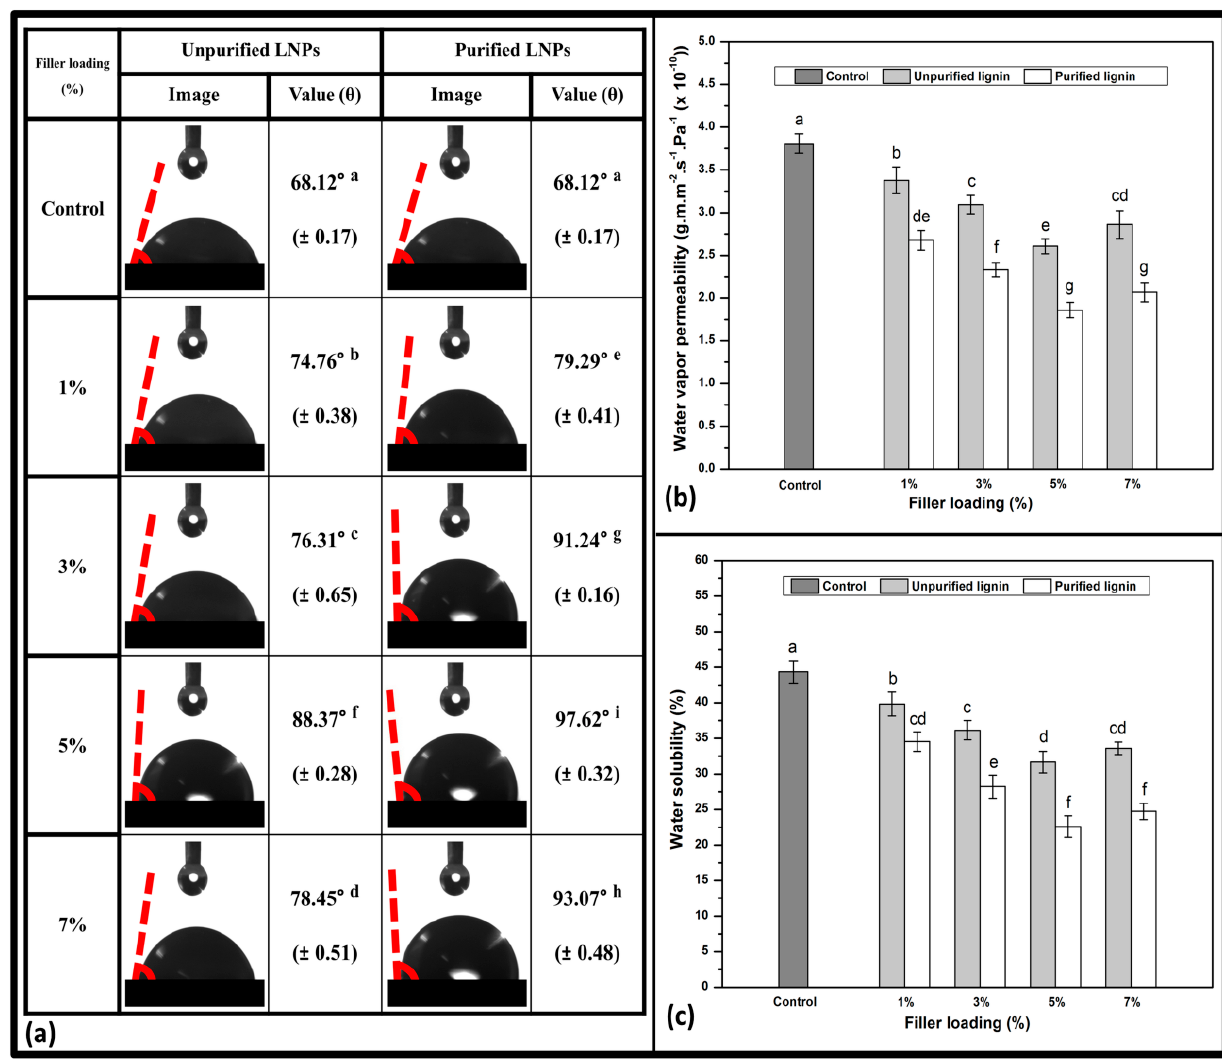
Figure 5. Hydrophobicity and physical properties of ( a ) contact angle, ( b ) water vapor permeability, and ( c ) water solubility of the LNP-reinforced bioplastic films. The same letters above the data bars indicate no significant difference in the values ( p < 0.05).